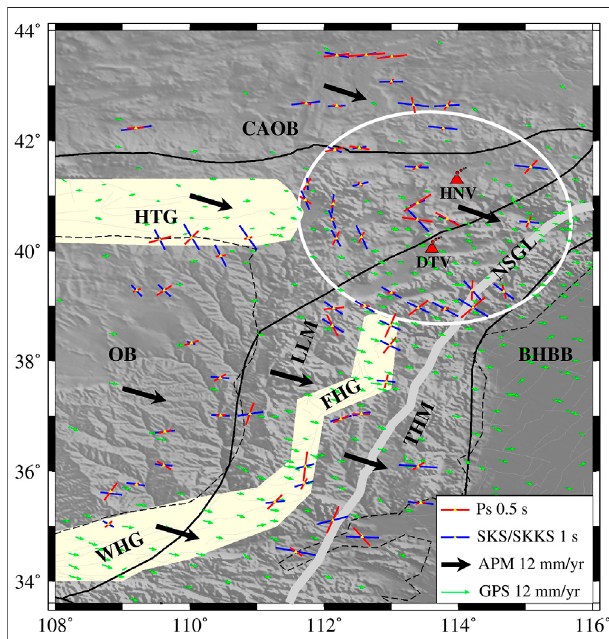
FIGURE 5 | Comparison of crustal anisotropy measured from the Moho Ps (the red bar lines) with measurements of the SKS/SKKS splitting (the blue bar lines, Chang et al., 2021), the GPS velocity (the green arrows, Zhao et al., 2015) and the absolute plate motion direction of the GSRM v2.1 model (the black arrows, Kreemer et al., 2014). White solid ellipse outlines the rotatingdistributionofthefastpolarizationdirectionsmeasuredfromtheMoho Ps. The abbreviations are the same as those de fi ned in the caption of Figure 1 .